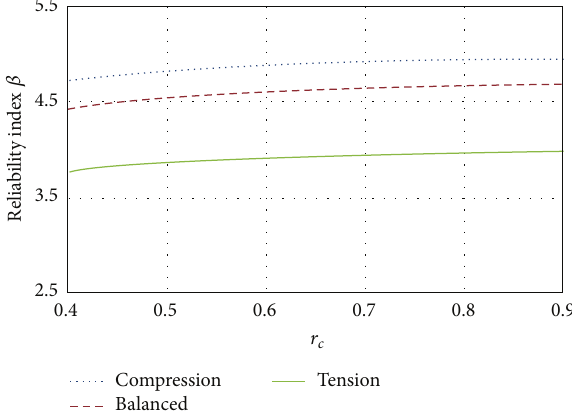
Figure 10: Influence of eccentricity on the structural reliability.